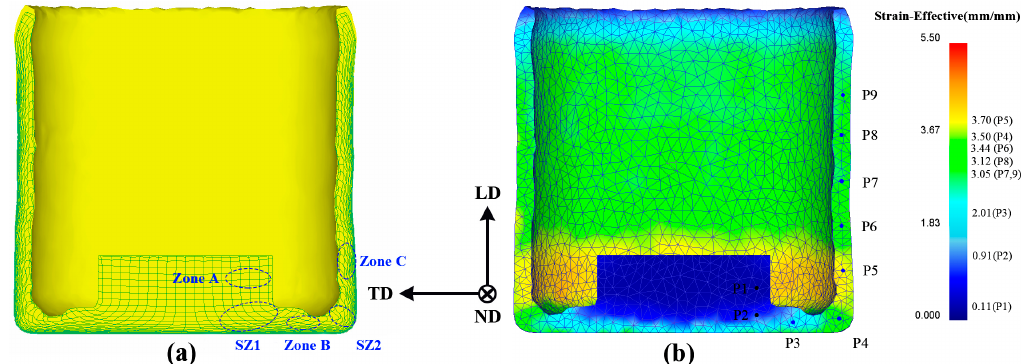
Figure 3. ( a ) The flow grid distribution and ( b ) effective strain distribution of the extruded part (TD, transverse direction; ND, normal direction; LD, longitudinal direction).